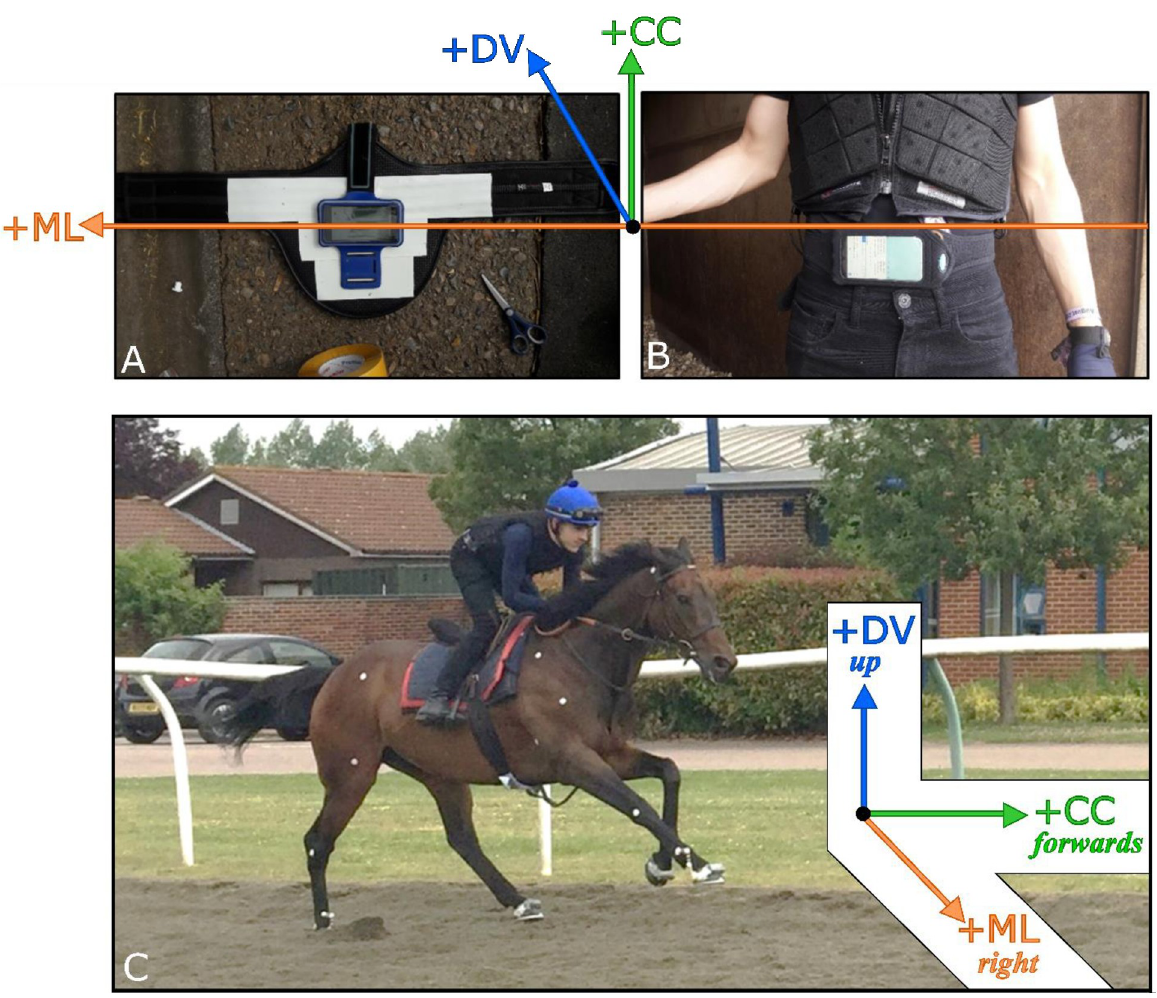
Fig 2. Orientation of the cranio-caudal (CC), medio-lateral (ML) and dorso-ventral (DV) acceleration axes in the SensorLog app. A) At the horse’s girth. B) At the jockey’s pelvis. C) At gallop, with the jockey in the two-point seat position. Quantifying horse-jockey interaction. Maximum displacements in positive (‘maxima’) and negative (‘minima’) directions were quantified along the CC, ML and DV axes and com- pared between horse and jockey in response to the different shoe and surface conditions. Due to restrictions of the SensorLog app and the phone operating system, horse and jockey sensor